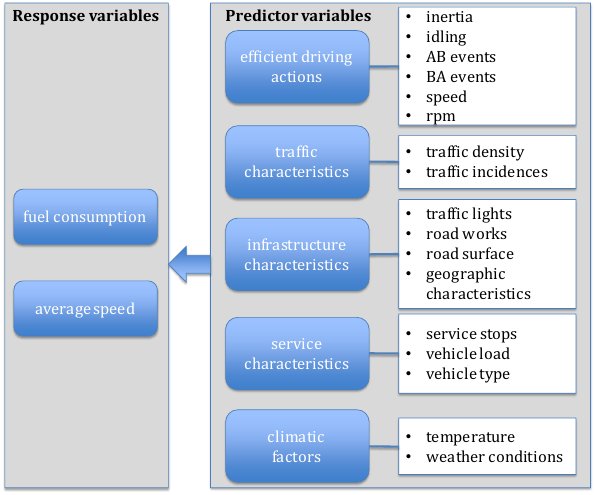
Figure 1. Ideal regression model.